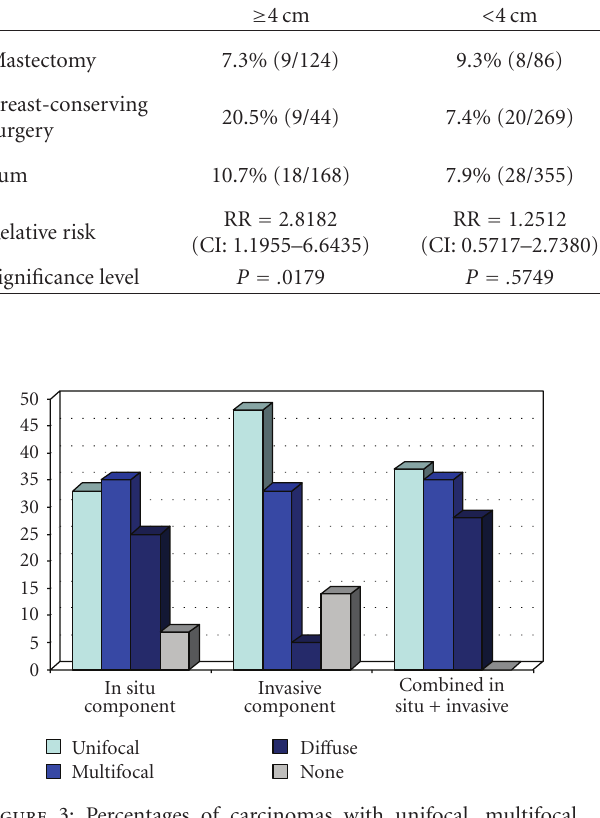
Figure 3: Percentages of carcinomas with unifocal, multifocal, and di ff use subgross patterns regarding the in situ component of the tumor, the invasive component, or both combined. Falun